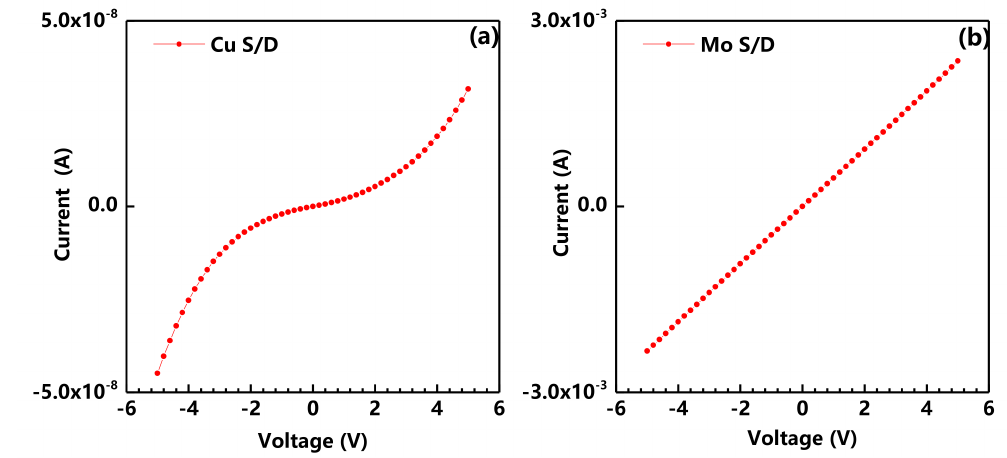
Figure 5. Current-Voltage (I-V) characteristics of a-IGZO film with different metal electrodes Cu S/D ( a ) and Mo S/D ( b ). The electrical stability of the S6 device under gate bias stress ( V G = 10 V for positive bias stress (PBS) and –10 V for negative bias stress (NBS), V D fixed at 10 V) is also investigated, as shown in Figure 6. It is clearly observed that the TFT exhibits excellent electrical stability with the V th shift of only 0.6 V for PBS and − 0.2 V for NBS, indicating that the Al 2 O 3 PVL can effectively protect the TFT from the ambient